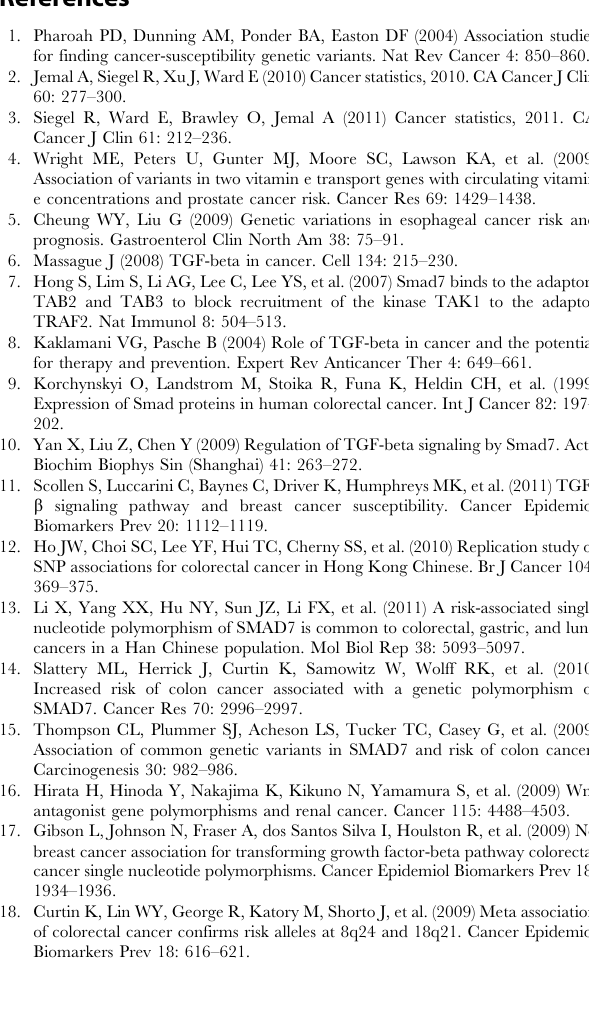
Figure S3 Forest plot of ORs with 95% CI for SMAD7 rs12953717 polymorphism and overall cancer risk (TC versus CC). Figure S4 Forest plot of ORs with 95% CI for SMAD7 rs12953717 polymorphism and overall cancer risk (TT versus TC + CC). Figure S5 Forest plot of ORs with 95% CI for SMAD7 rs12953717 polymorphism and overall cancer risk (TT + TC versus CC).